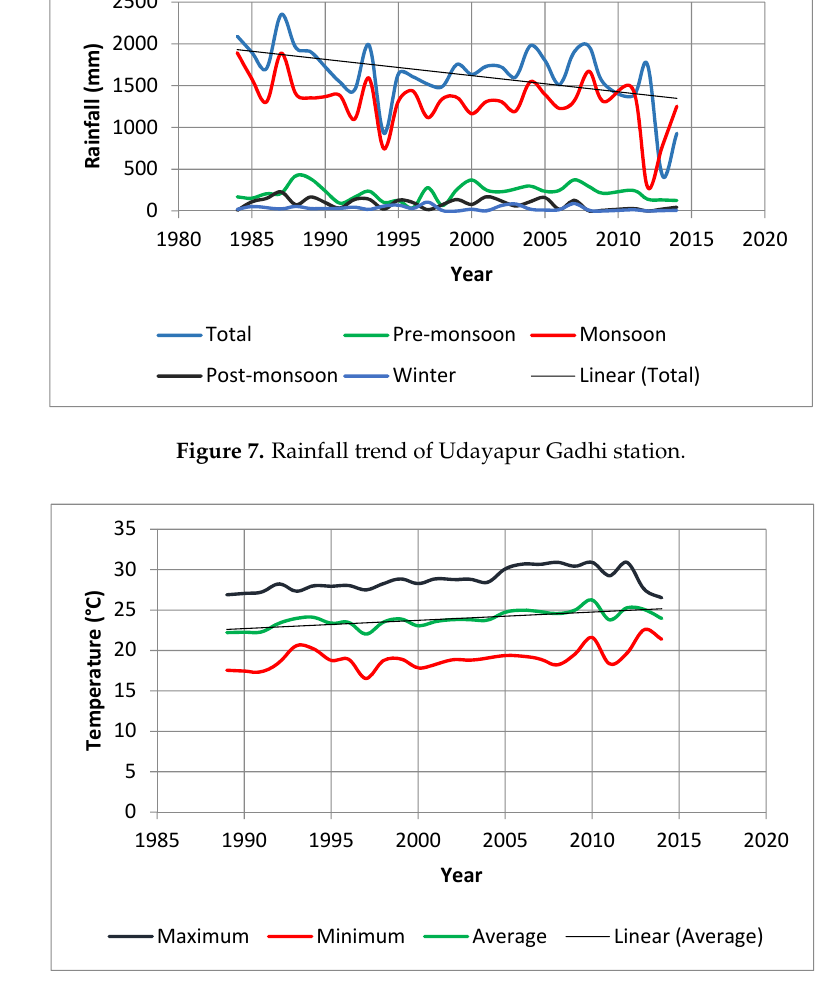
Figure 8. Temperature trend of Udayapur Gadhi station.